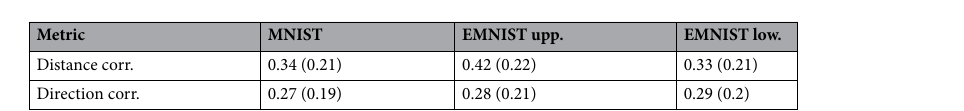
Table 1. Average Pearson correlation coefficient (corr.) for fixation sequences for the same class. For any fixation, distance is Euclidean and direction is measured as the polar angle with respect to the center of stimuli as origin. Std. dev. are included in